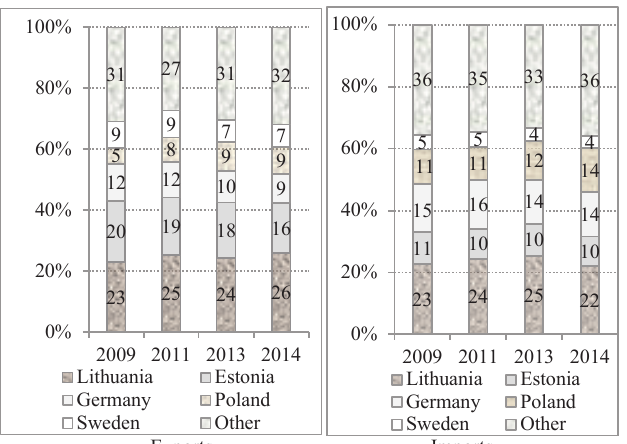
Fig. 4. Main trading partners of Latvia in the EU (Trade Map, 2014).